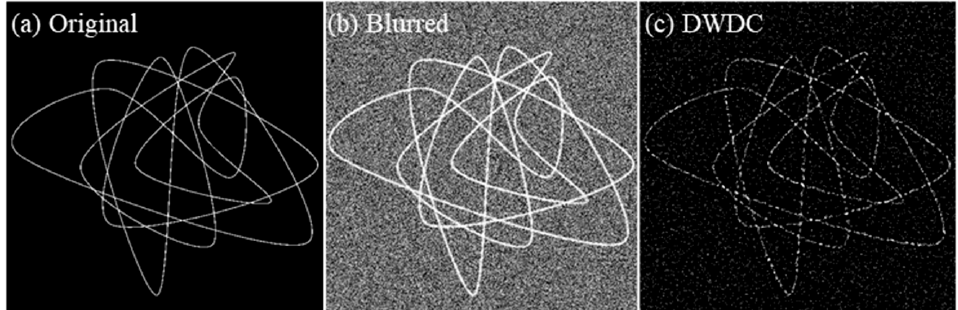
Figure 6. Comparison between the ( a ) ground truth image, ( b ) the blurred and noised image, and